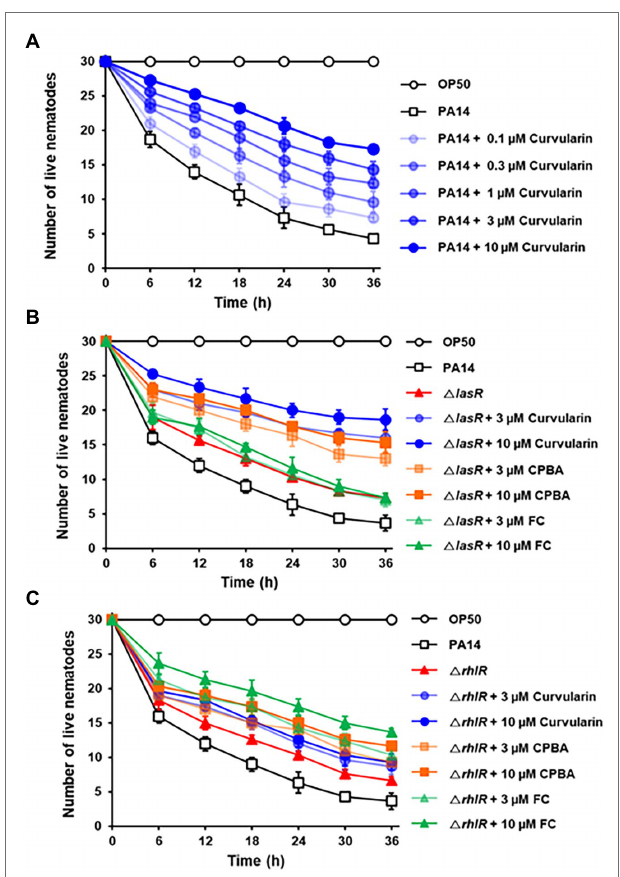
FIGURE 9 | In vivo antivirulence activity of curvularin. Antivirulence activity of curvularin in a C. elegans infection model. Thirty worms were introduced on lawns of E. coli OP50, wild-type PA14 (A) , Δ lasR mutant (B) , or Δ rhlR mutant (C) on plates in the presence of different concentrations of curvularin. Live nematodes were counted every 5 h for 30 h. FC and CPBA are known antagonists of LasR and RhlR, respectively. Two independent experiments were performed in triplicate, and the mean ± SD values are displayed in each